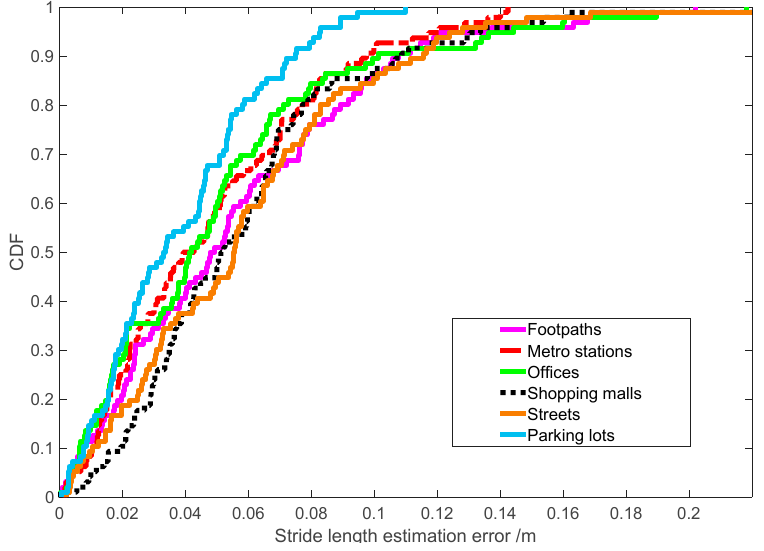
Figure 14. Estimation error of stride-length in typical scenarios.